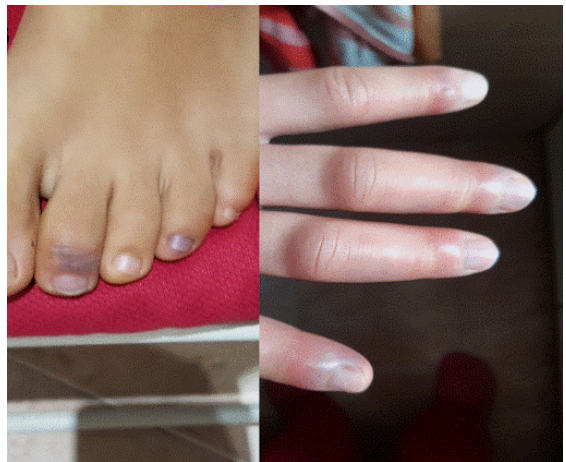
Figure 3. Violaceous macules on fingers and toes compatible with palpable purpura caused by cutaneous small vessels vasculitis observed 7 days after booster Pfizer-BioNTech vaccination.